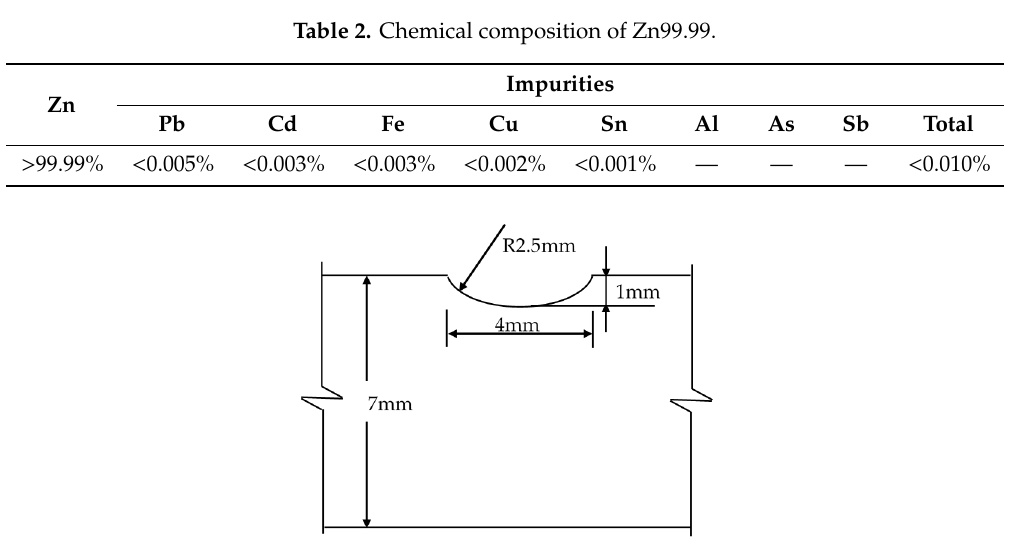
Figure 1. Schematic diagram of machine-cut notch.